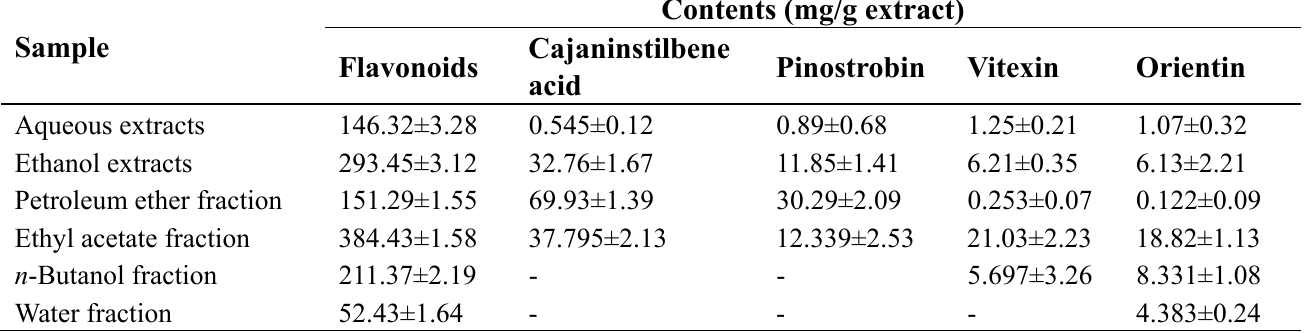
Table 1 Contents of total flavonoids and main components in the extracts and four fractions of pigeonpea leaves ( n =3).